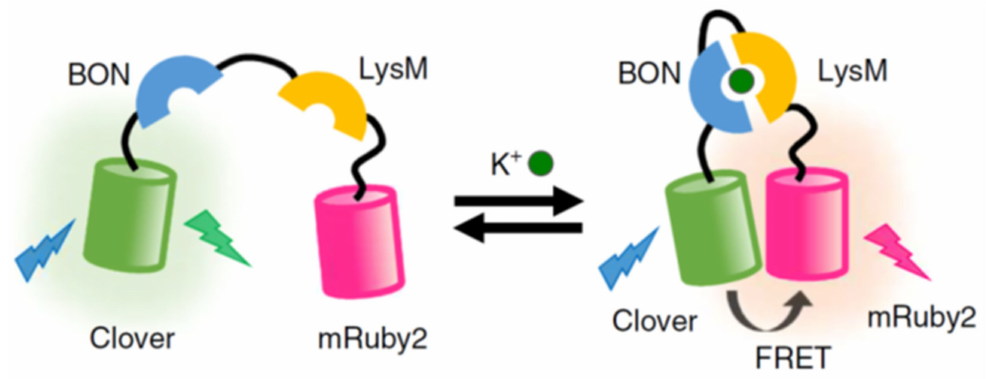
Figure 3. Schematic of the KIRIN1-GR FRET system where emission at a higher wavelength is detected after potassium binding. Image adapted with permission [189]. Copyright 2019 Springer